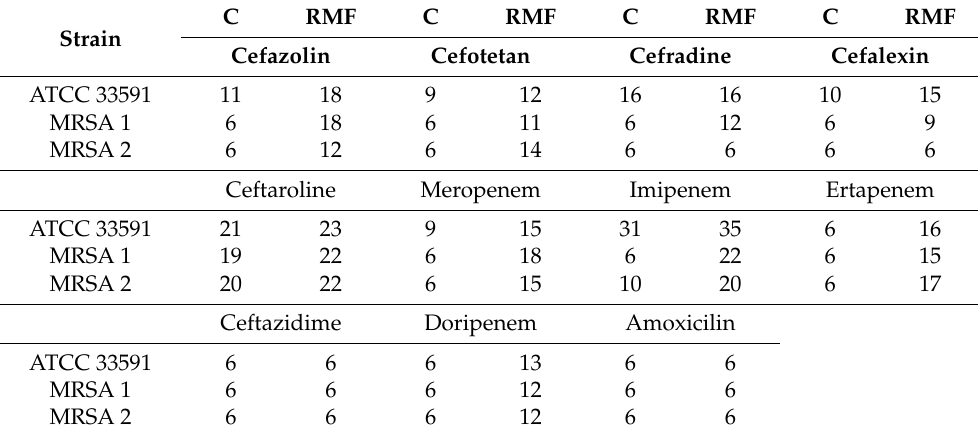
Table 3. Growth inhibition zones (mm) of MRSA strains around discs with different β -lactam antibiotics in RMF-exposed (5 Hz) and control, unexposed cultures. Strain